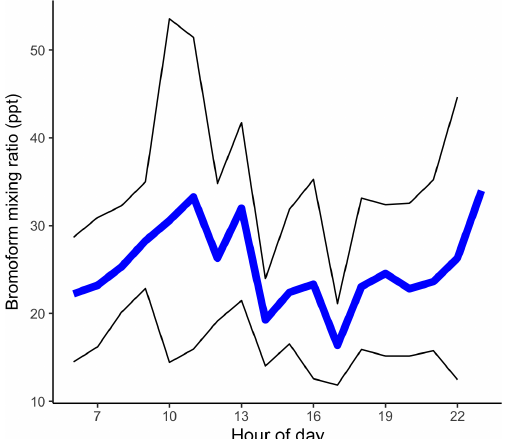
Figure 4. Mean diurnal cycle, calculated from all measurements binned by hour. The black lines above and below signify the 95% confidence